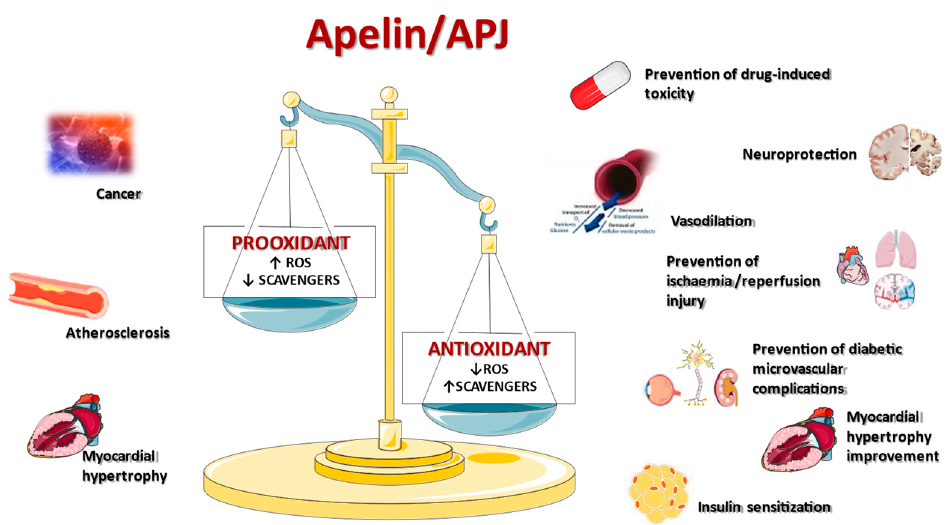
Figure 2. Prooxidant and antioxidant functions of the apelin/APJ system.